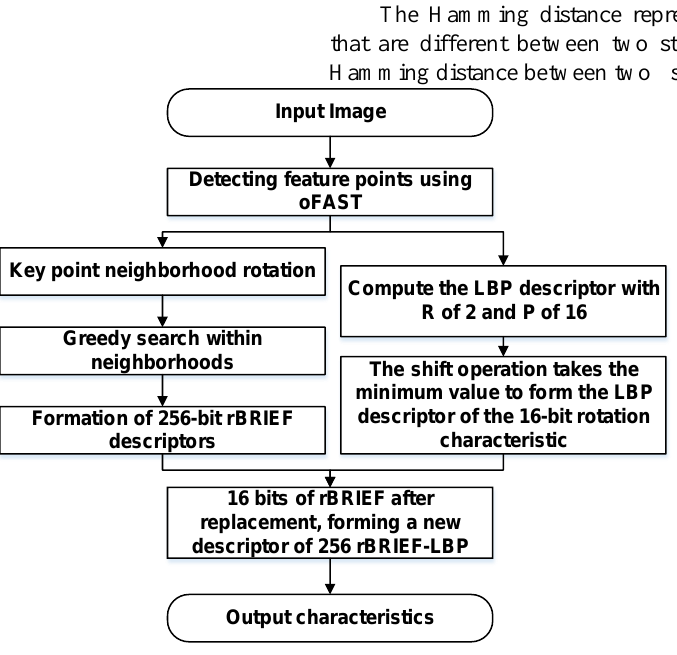
Figure 5. rBRIEF-LBP fusion descriptor generation process